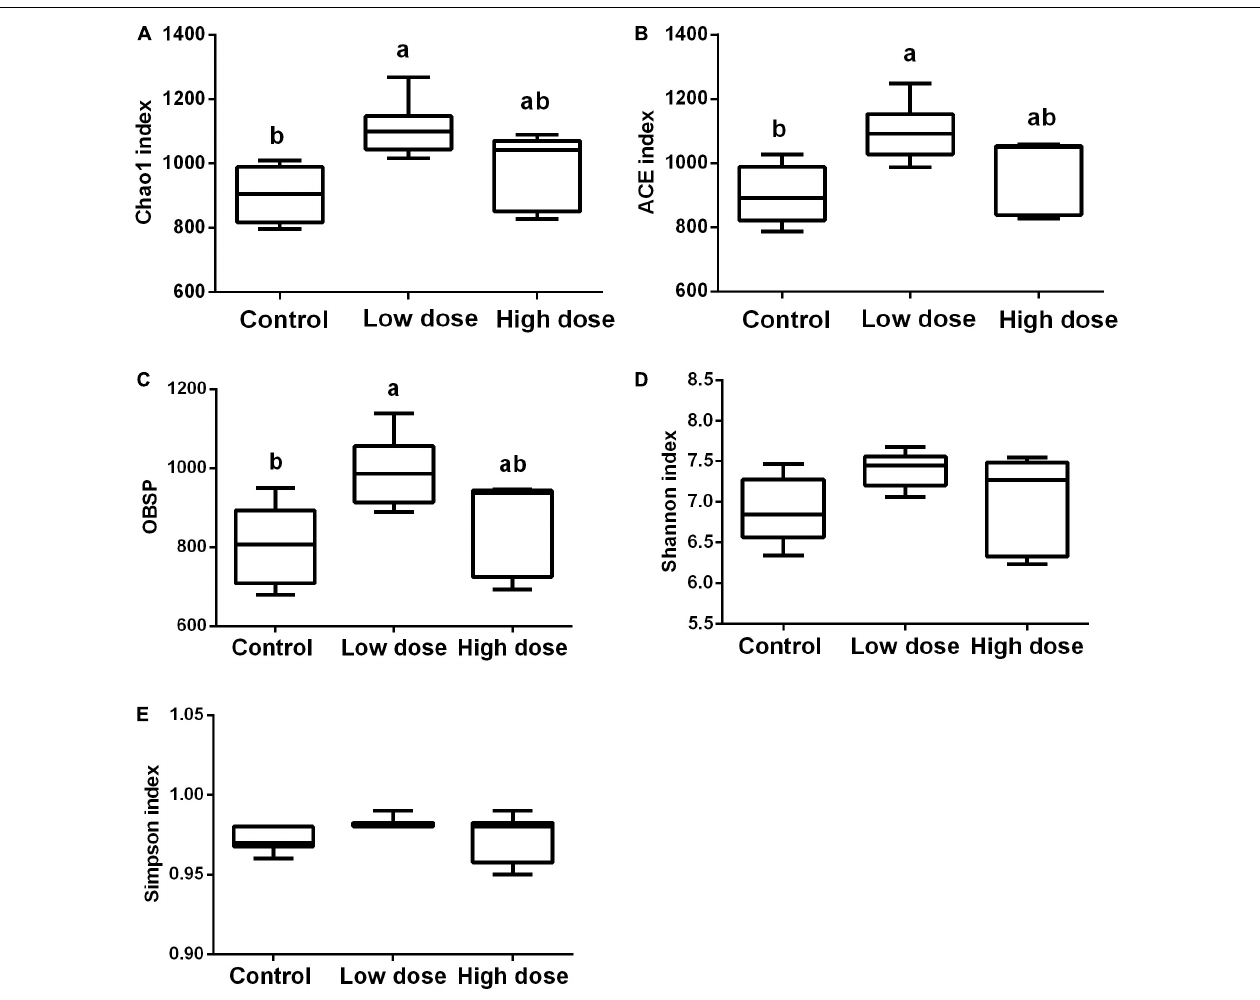
FIGURE 2 | Differences in the cecal microbiome composition among control group (0 mg/kg 6-MBOA), low 6-MBOA dose group (1 mg/kg 6-MBOA) and high 6-MBOA dose group (2 mg/kg 6-MBOA) in adult male Brandt’s vole. (A) chao1; (B) abundance-based coverage estimator (ACE); (C) Observed species (OBSP); (D) Shannon index; (E) Simpson index. Error bars indicate standard errors. Same letters connect bars with no significant differences at P < 0.05 ( n =